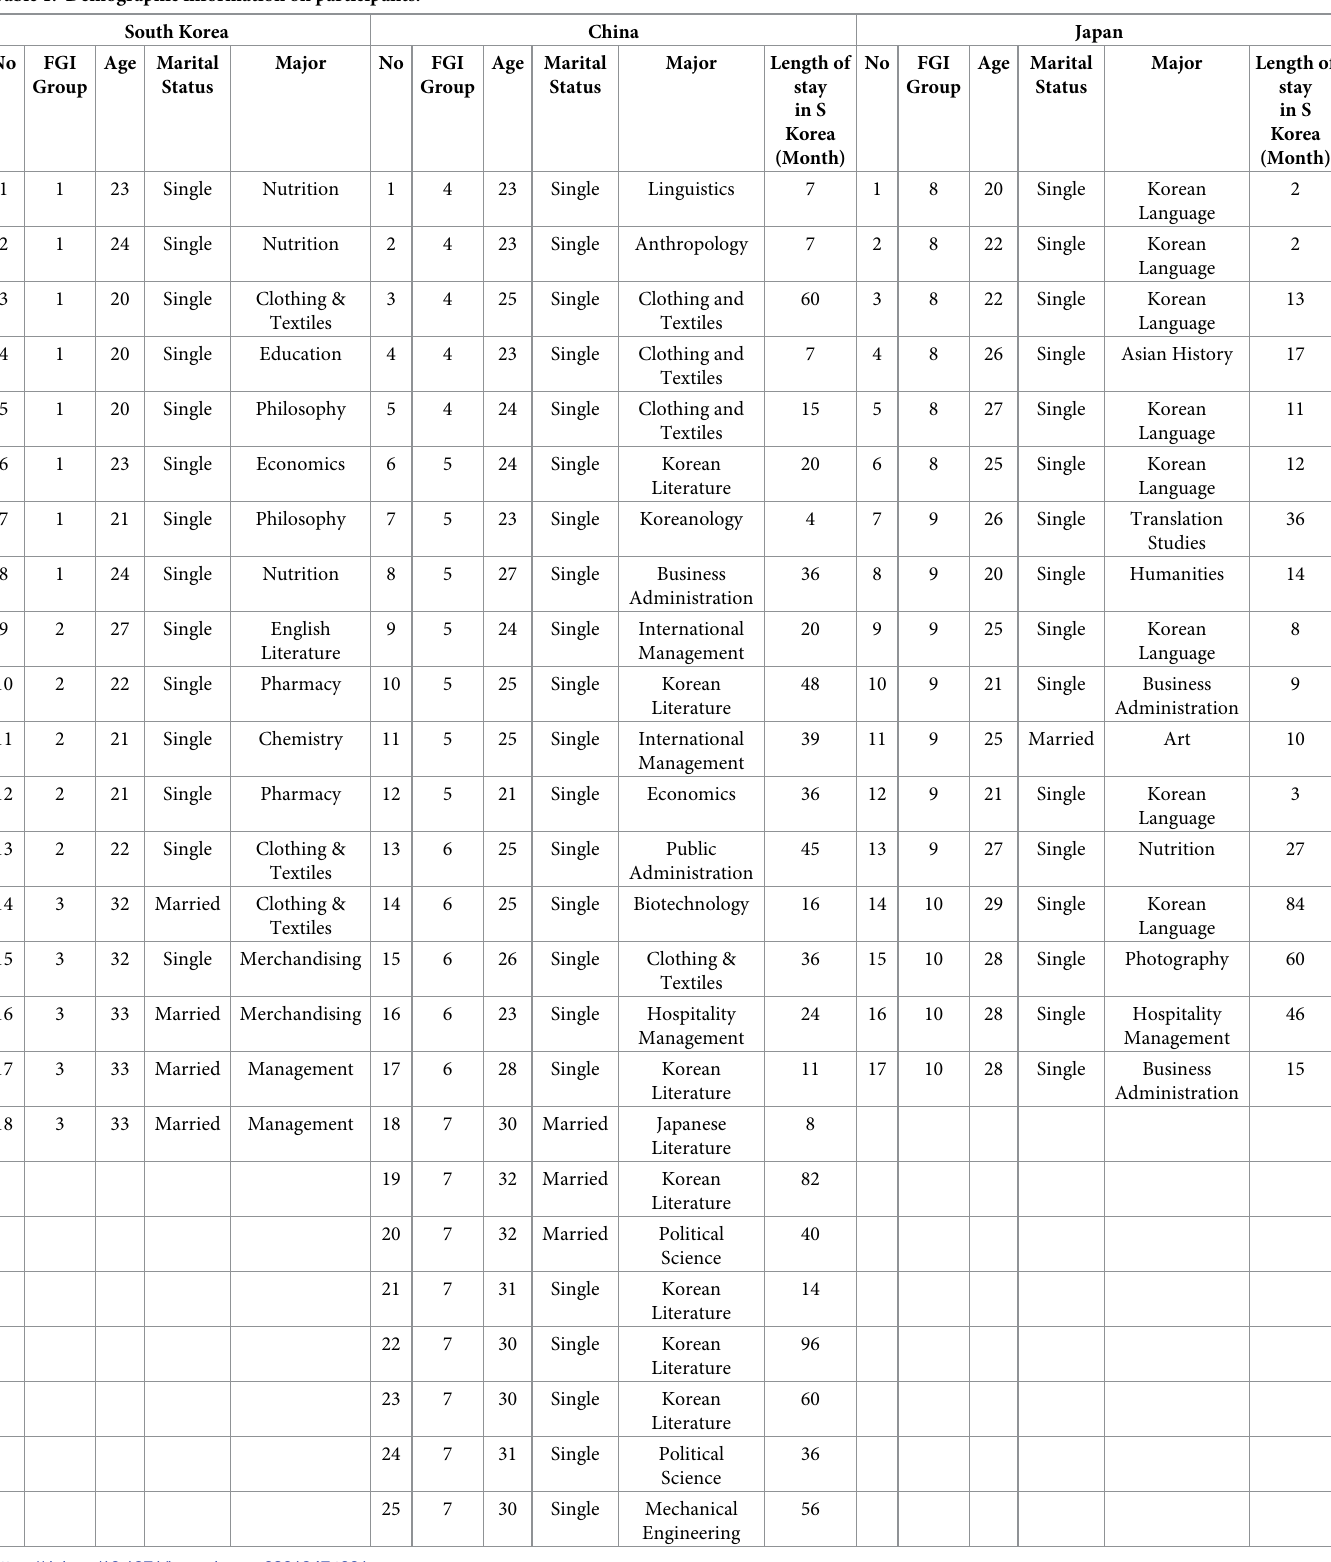
Table 1. Demographic information on